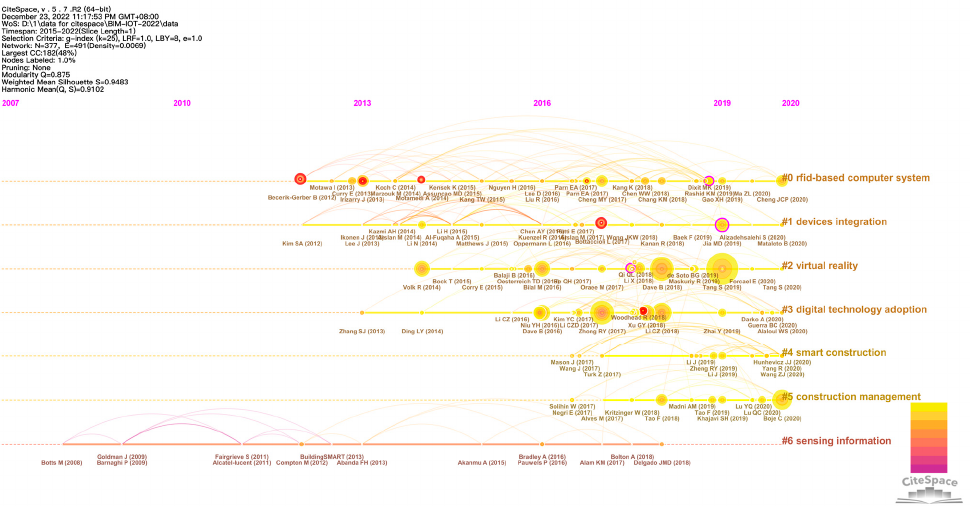
Figure 4. Timelines of co-citation clusters in Figure 3 (generated by the authors). Table 1 lists the details of clusters #0 ‘rfid-based computer system’, #1 ‘devices